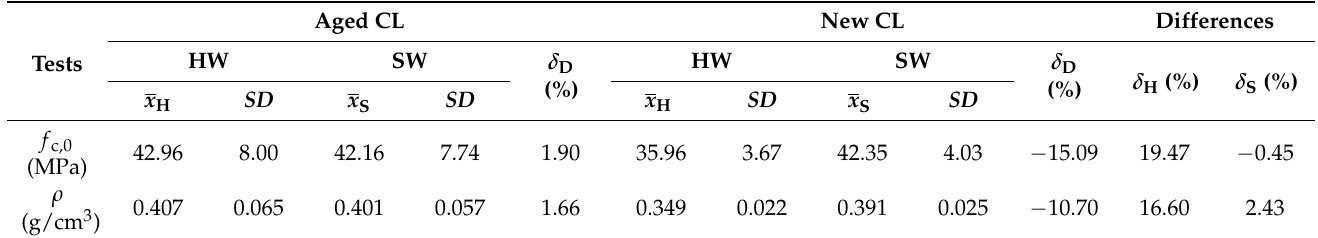
Table 3. Parallel-to-grain compressive strength ( f c,0 ) and density ( ρ ) of standard specimens.